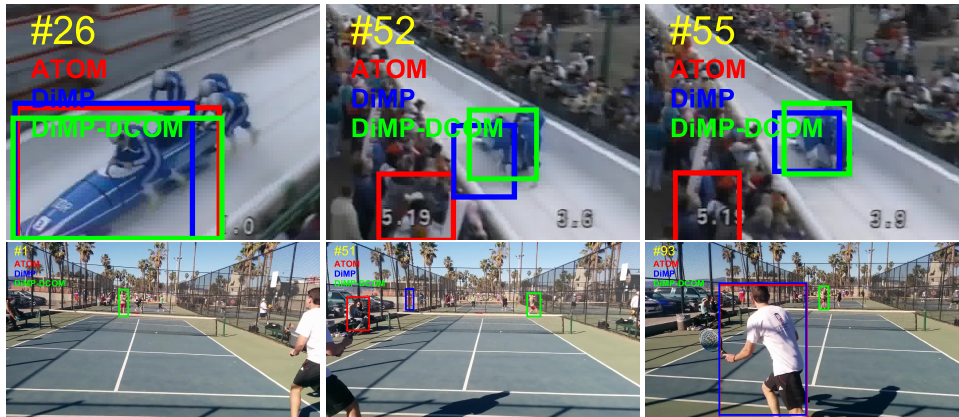
Figure 5. Visualization tracking results of DiMP-DCOM (green), DiMP (blue), and ATOM (red) on the challenging sequences from GOT-10k [21]. We can see that DiMP-DCOM shows stronger ability of bounding box estimation and better accuracy throughout tracking. Best viewed with zooming